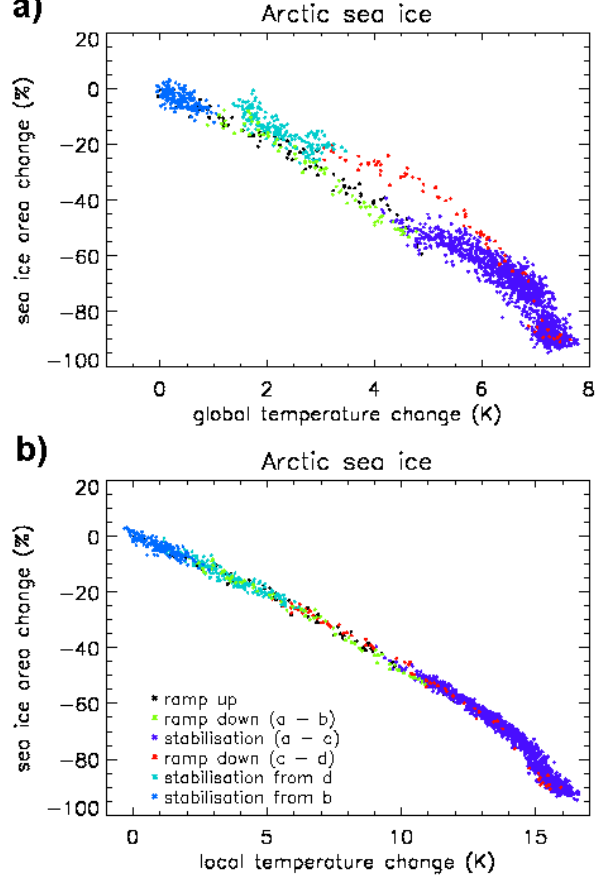
Fig. 2. The sensitivity of Arctic sea ice area change to (a) global Figure 2. The sensitivity of Arctic sea ice area change to a) global temperature change temperature change and (b) local temperature change. Colours refer to the CO 2 trajectory markers specified in Fig. and b) local temperature change. Colours refer to the CO2 trajectory markers specified in figure 1.